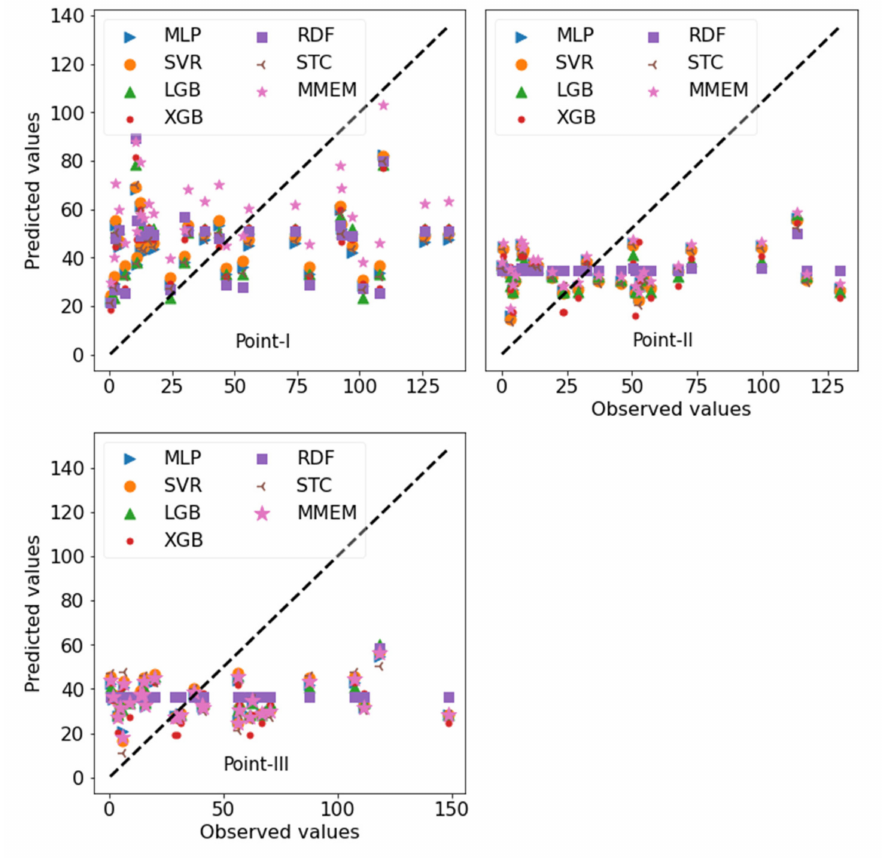
Figure 5. Comparison of the resemblance of dry and wet events produced by regression